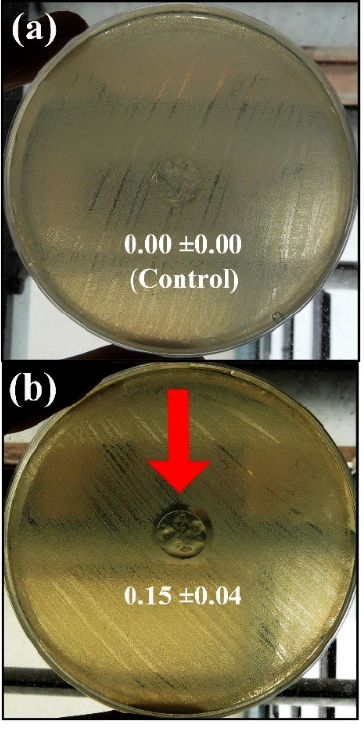
Figure 7. Results of the antibacterial test of CNFs in alginate films. Control alginate films without CNFs ( a ) and alginate films with a low amount (0.1% w/w ) of CNFs ( b ) against the methicillin-resistant Staphylococcus epidermidis (MRSE) bacteria by the agar disk diffusion method at 37 ◦ C after 24 h of incubation. The bacterial inhibitory halo produced by the antibacterial material film of calcium alginate/CNFs can be clearly observed (red arrow)